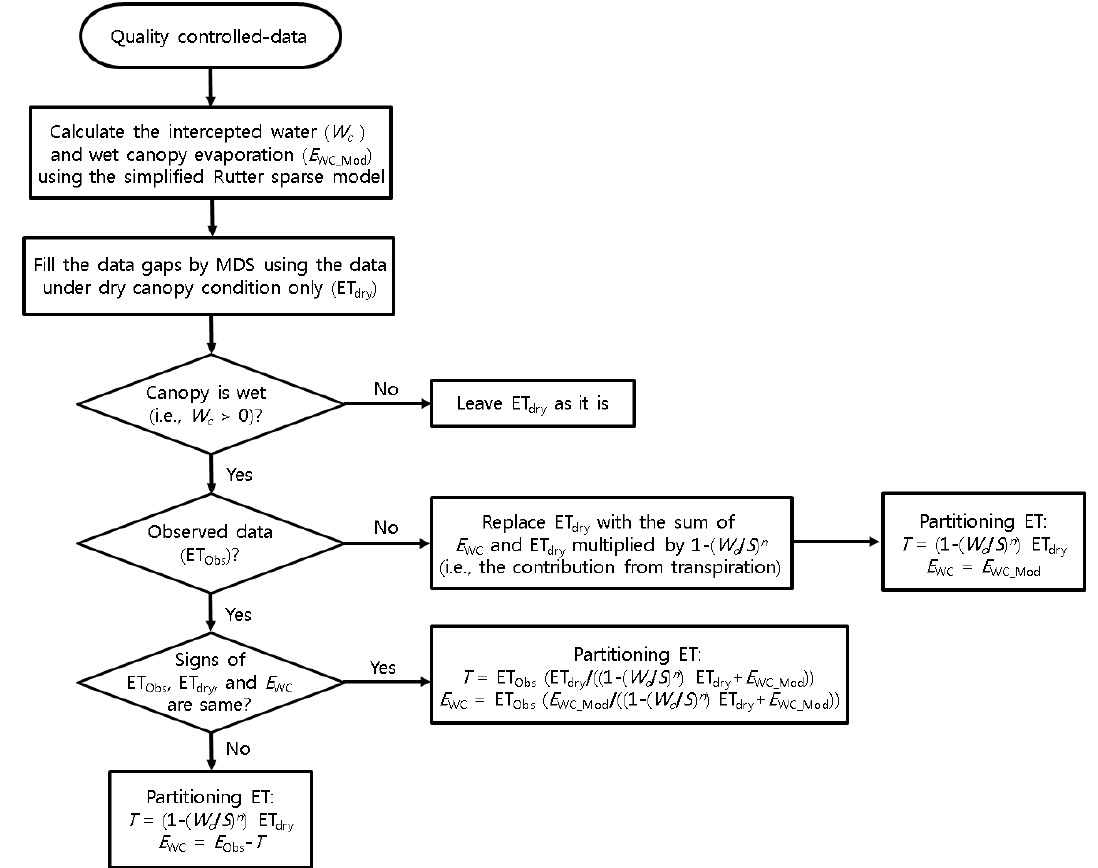
Figure 1. Flowchart of the gap-filling and partitioning technique for evapotranspiration.